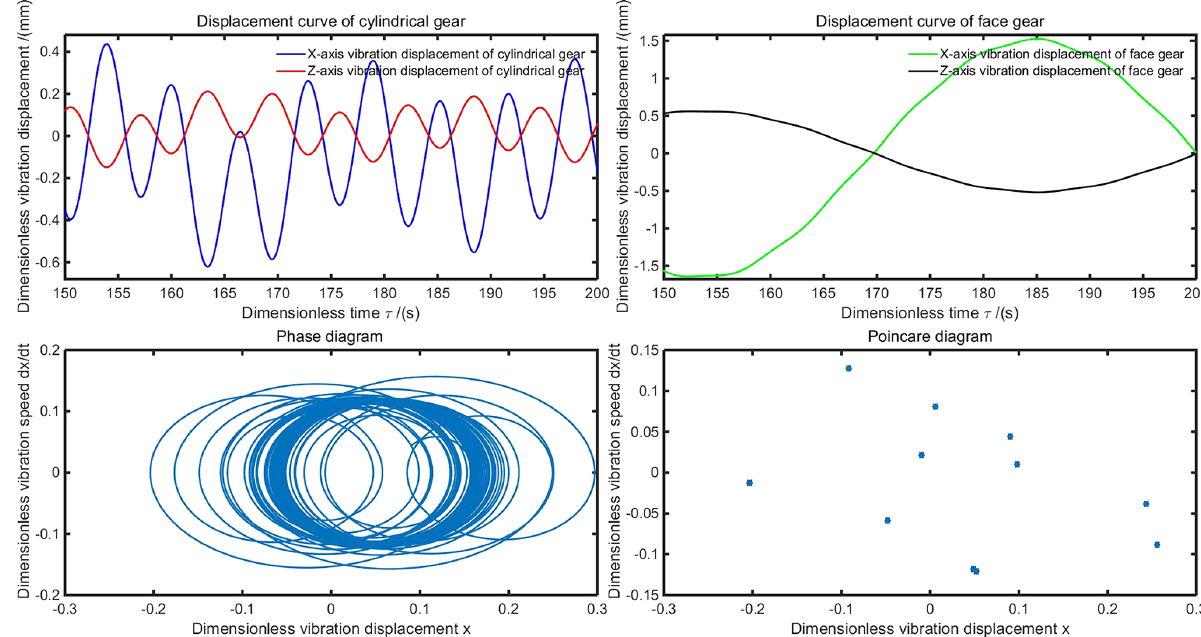
Figure 16. Displacement, phase, and Poincare diagrams of 2nd stage face gear pair nonlinear